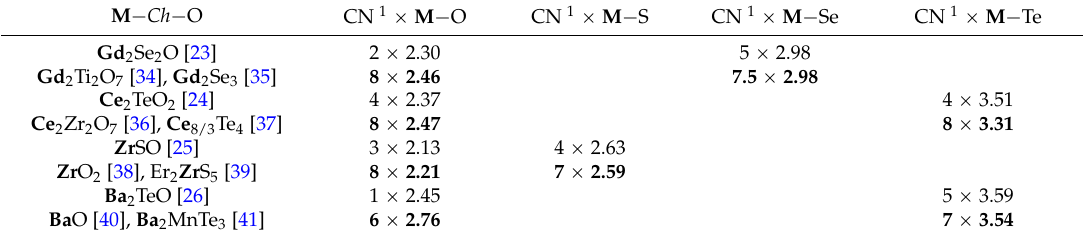
1 Average coordination number.